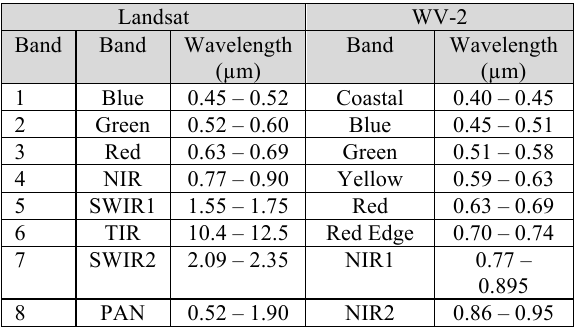
Table 1. Spectral properties of the Landsat and WV-2